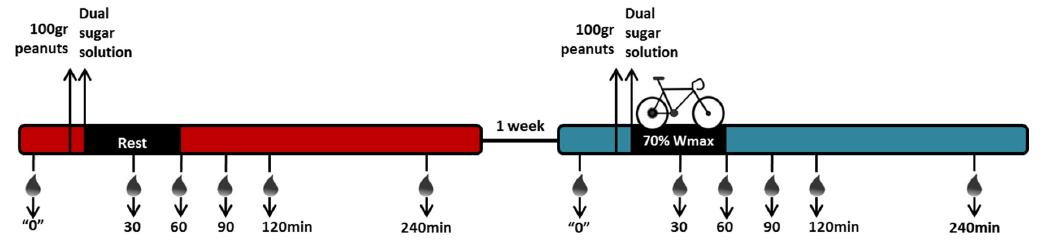
Figure 1. Schematic overview of study set up.